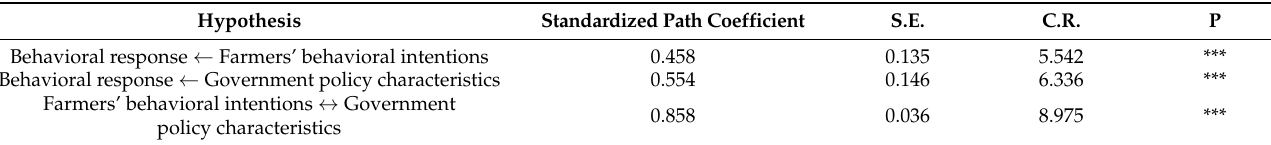
Table 6. Results of model hypothesis